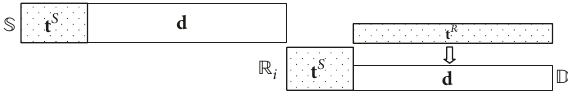
Figure 2: Structure of one frame with relay-assisted training.